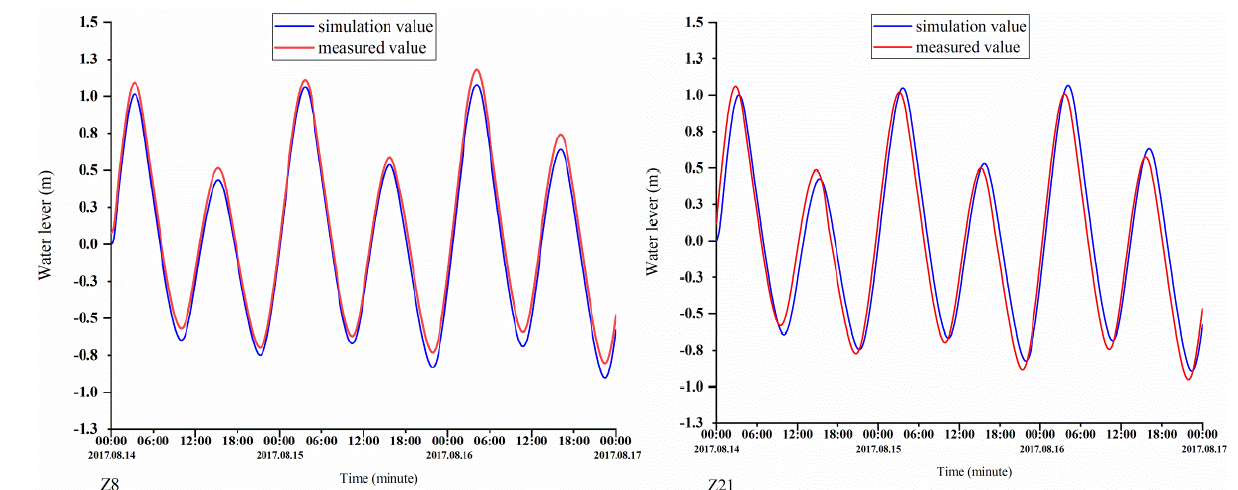
Figure 5. Verification of the tidal levels at the Z4, Z8, Z11, and Z21 stations.